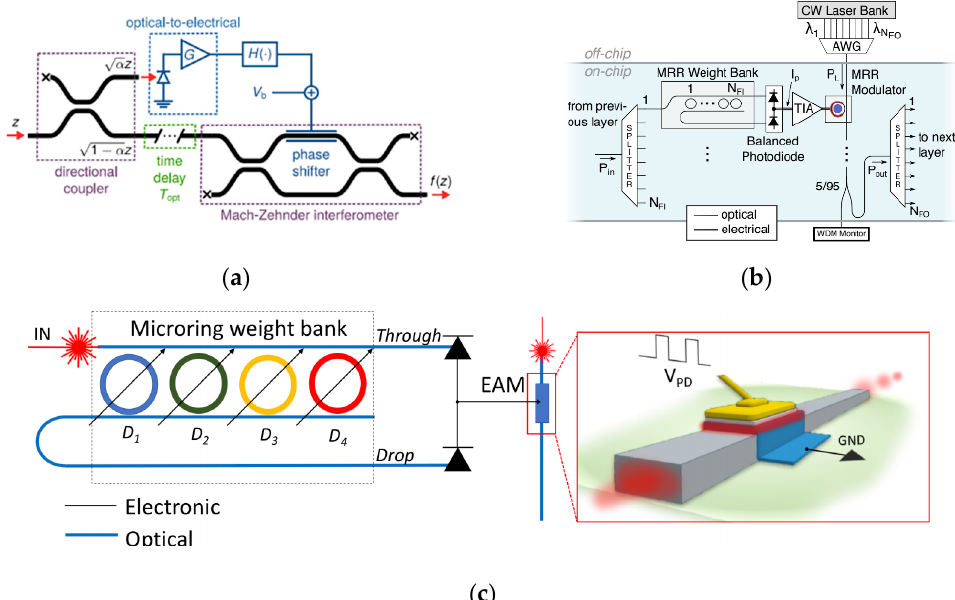
Figure 8. Optical modulator implementation diagram. ( a ) MZI modulator [38], ( b ) electro-absorption modulator [39], ( c ) micro-ring cavity modulator [40].